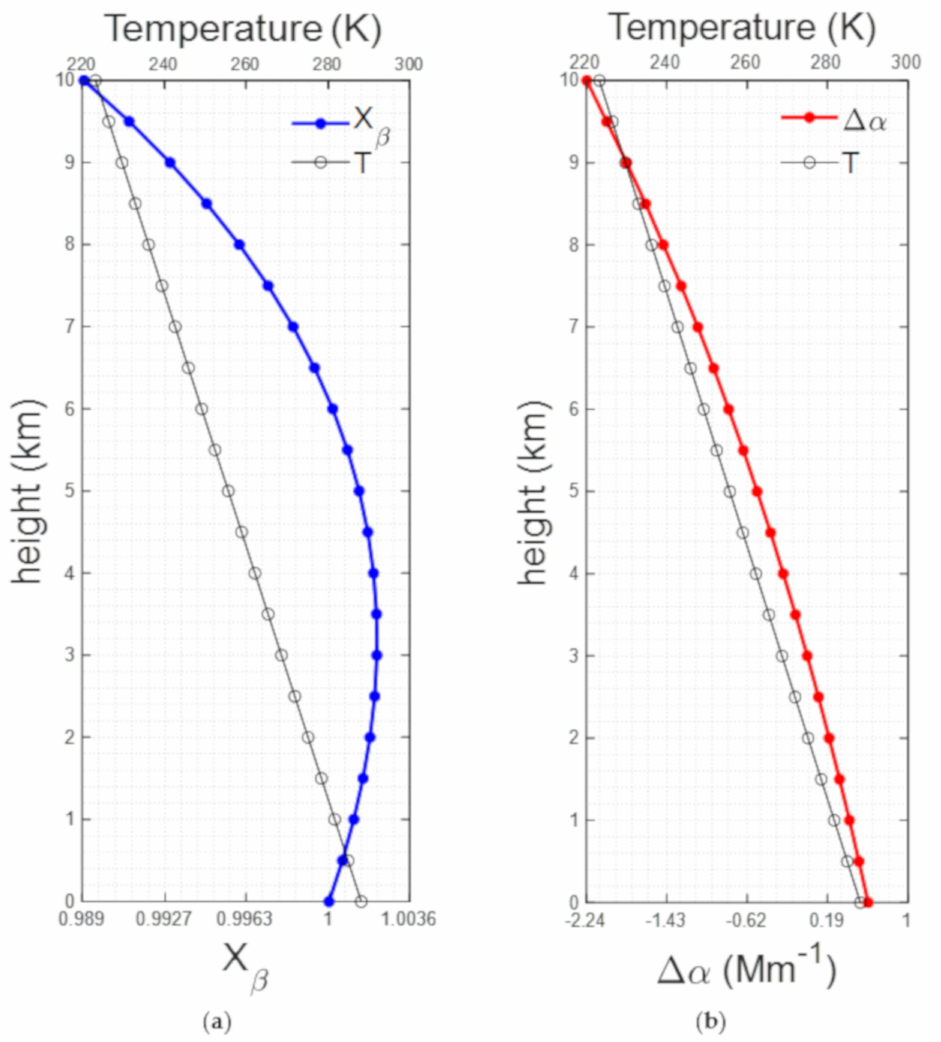
Figure 6. ( a ) Temperature-induced variation for the backscatter coefficient ( b ) temperature-induced error for the extinction coefficient. Temperature profile from U.S. Standard